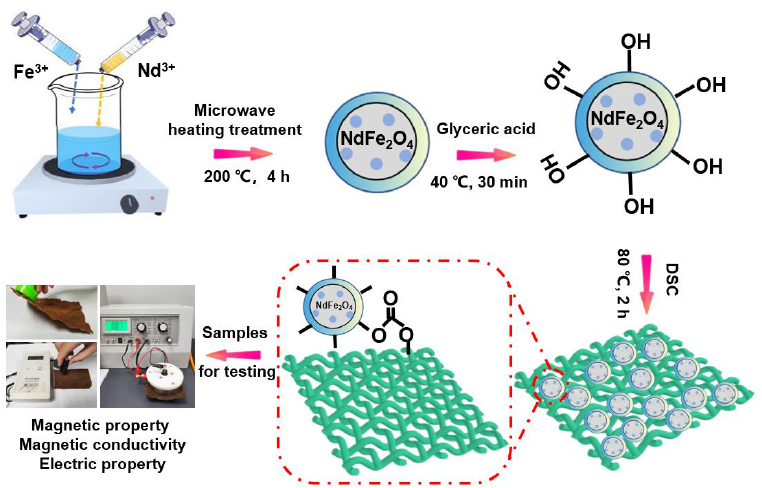
Figure 1. Illustration of the preparation process of the reliable magnetic protective